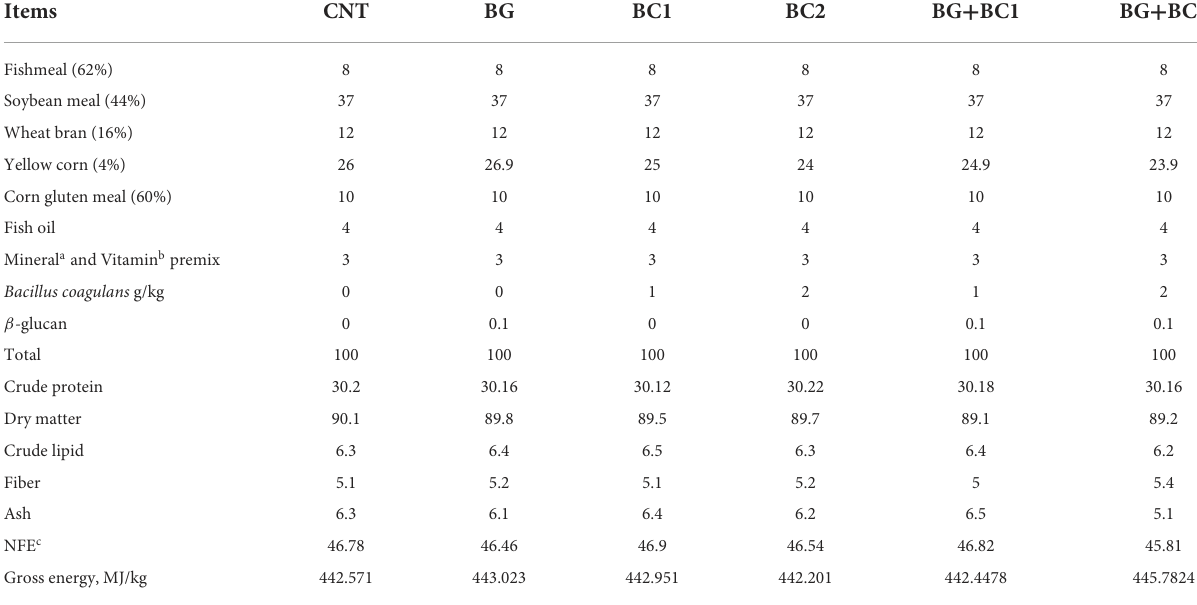
TABLE 1 Formulation and chemical composition of the basal diet (% dry matter). Items CNT BG BC1 BC2 BG + BC1 BG + BC2 Fishmeal (62%)